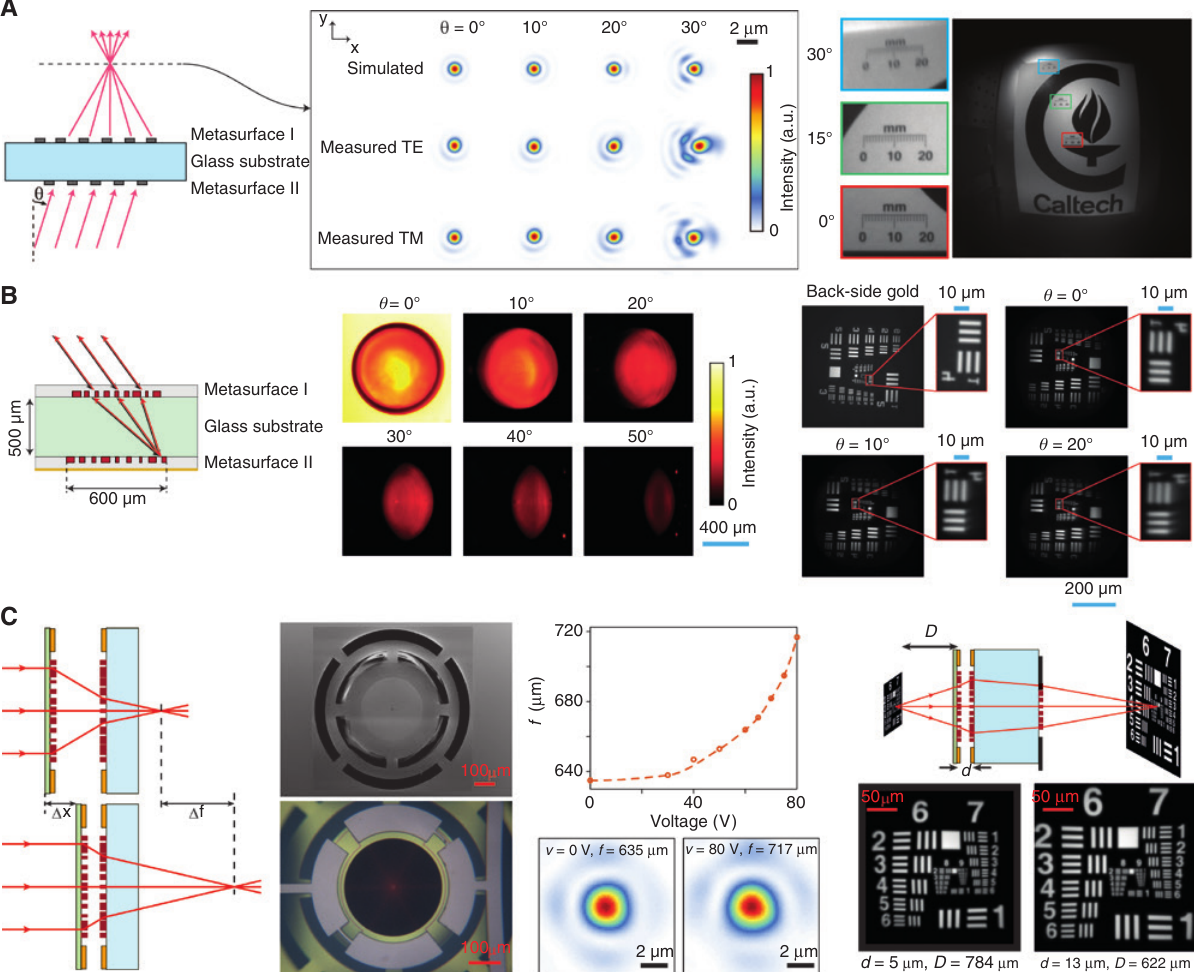
Figure 10: Metasystems. (A) A wide-angle metasurface doublet lens. A schematic illustration of corrected focusing by the monolithic metasurface doublet lens, composed of two cascaded metasurfaces, is shown on the left. Simulated and measured focal plane intensity profiles of the